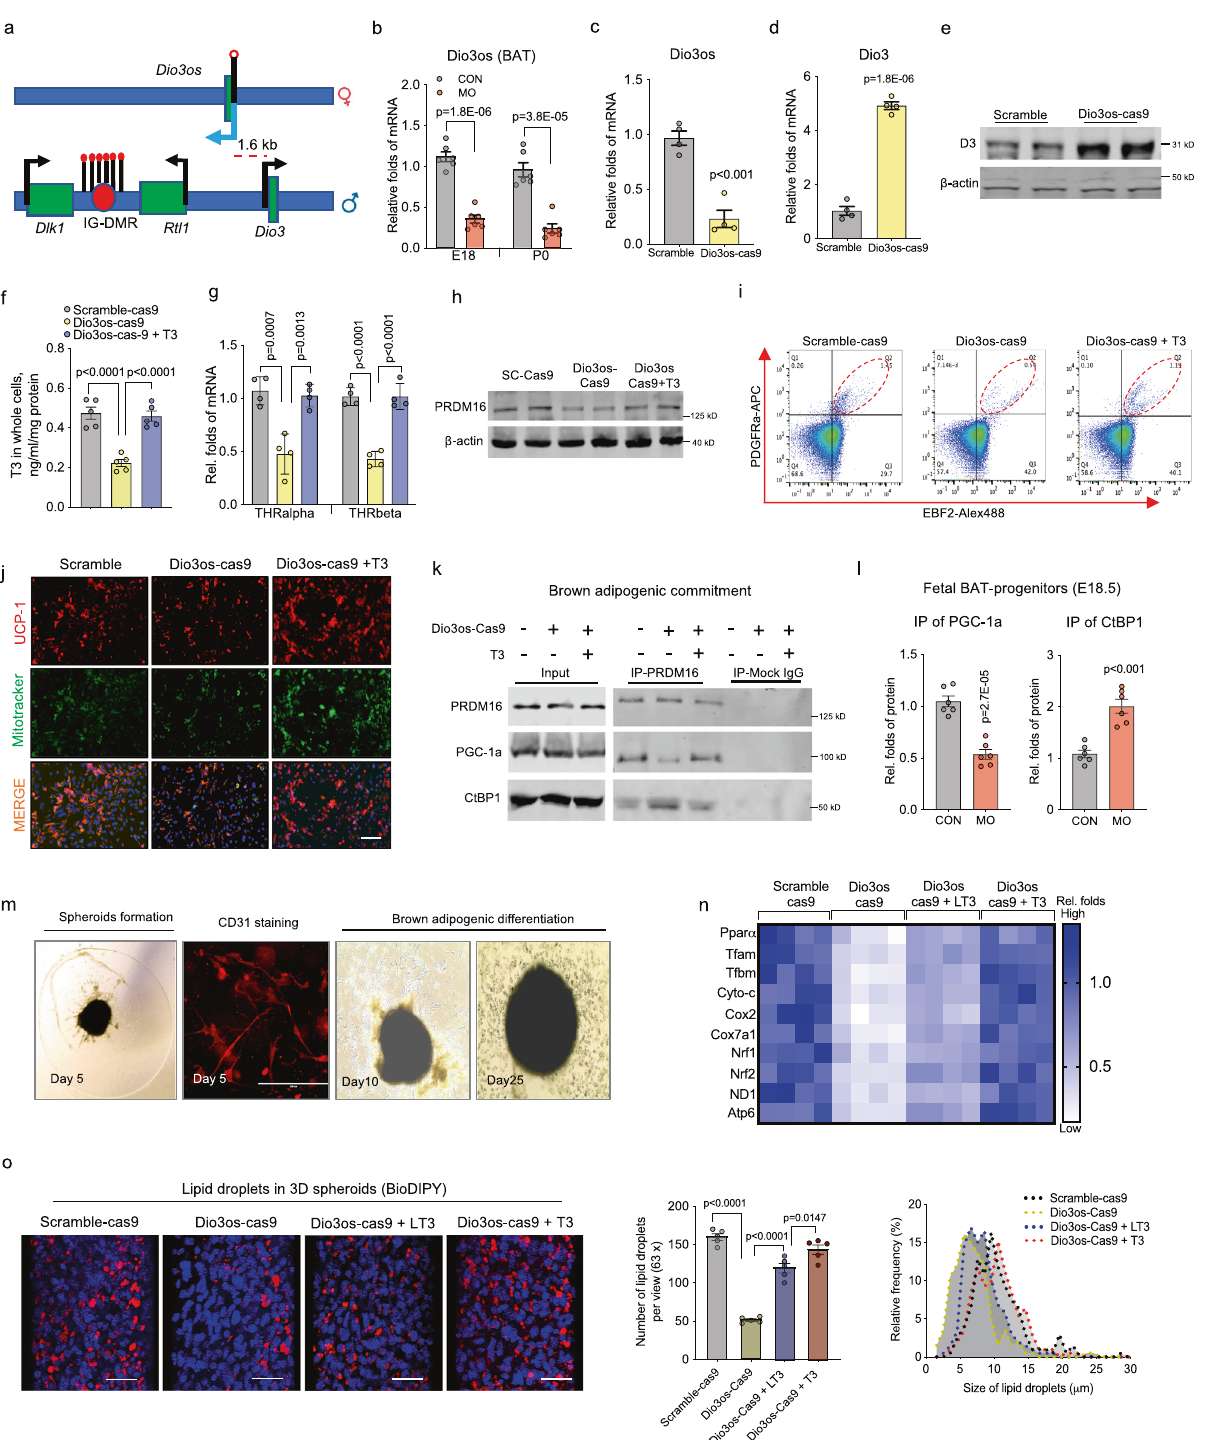
(Supplementary Fig. 9a – c), which reduced intracellular T3 con- centration (Supplementary Fig. 9d) and Thr α and Thr β expres- sion (Supplementary Fig. 9e). Such inhibition in spheroids was reversed by T3 supplementation (Supplementary Fig. 9d, e). T3 addition also recovered PRDM16 expression, and the formation of PGC-1a/PRDM16 protein complex (Supplementary Fig. 9f, g). After 20 days of brown adipogenic differentiation in Matrigel, Dio3os knockdown resulted in fewer lipid droplets in spheroids (Fig. 4o). Expression of thermogenic and